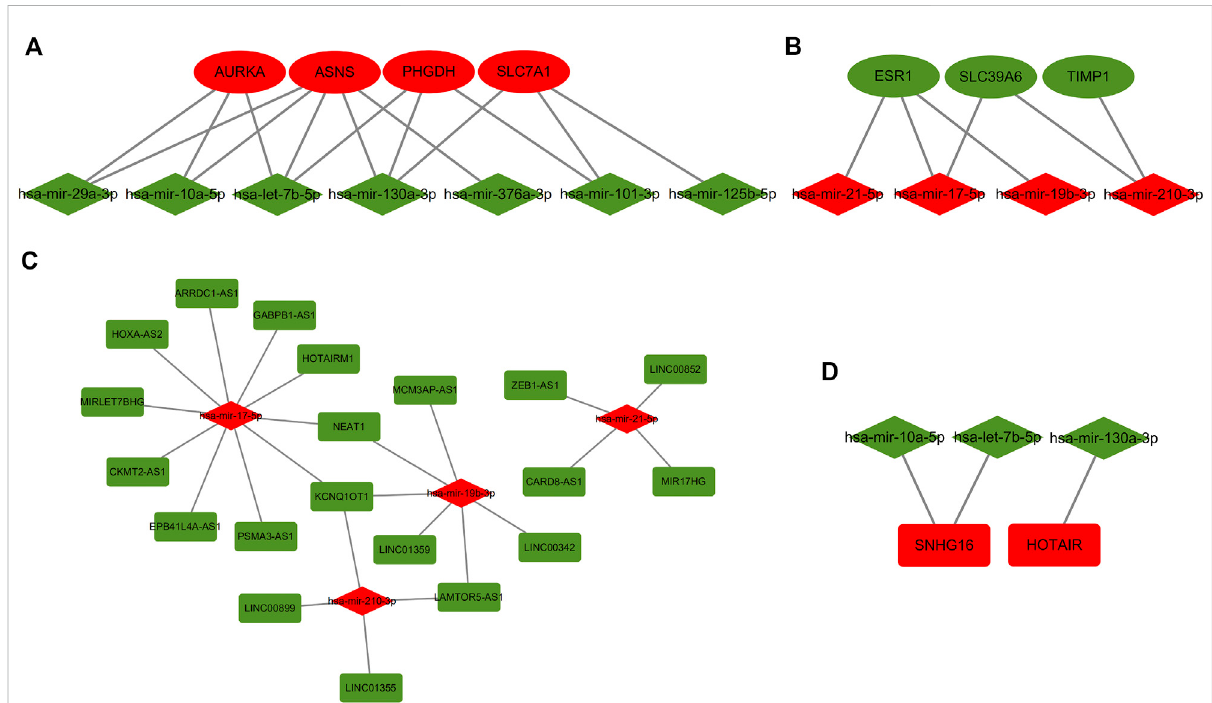
FIGURE 5 RegulatorynetworkofmiRNA-mRNAandmiRNA-lncRNAforTMX-resistantbreastcancer. (A , B) mRNA-miRNAcorrespondence. (C , D) miRNA- lncRNA correspondence. Oval shape represents mRNA, diamond shape represents miRNA, and rectangle shape represents lncRNA. Red color represents upregulated genes and green color represents downregulated